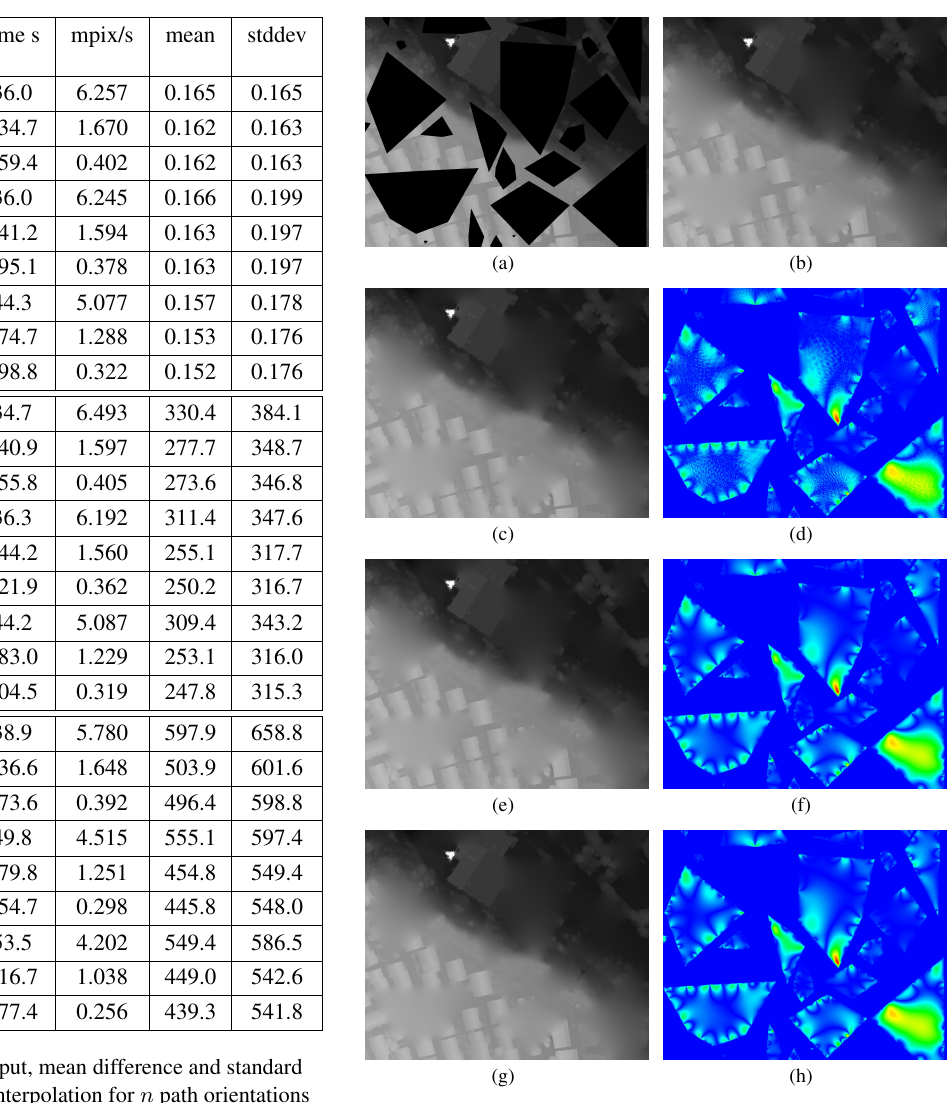
DSM and PAN data. Also, the slowdown is greater for the RGB than the graylevel bitmaps, particularly when switching from 64 to 256 orientations. Since all input gets converted to floating- point samples, there is only marginal deviations between the single-channel DSM and PAN bitmaps. When comparing the execution speed for the RGB and PAN images, an average